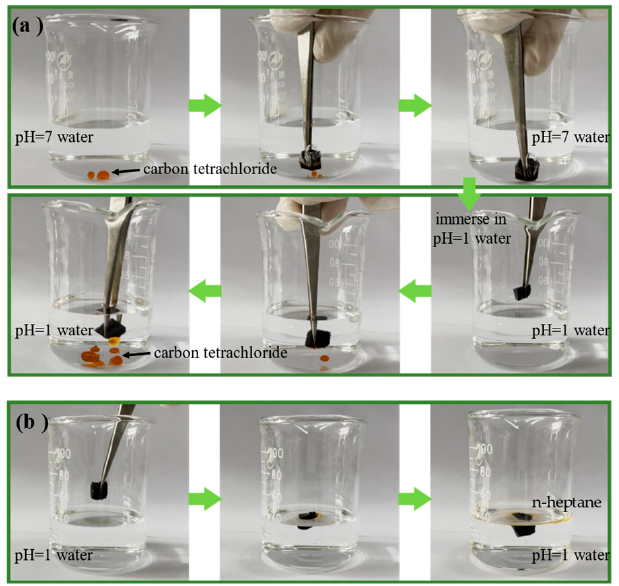
Figure 4. ( a ) Oil (carbon tetrachloride dyed with Sudan III) absorption in pH = 7 water and desorption in acidic water (pH = 1) by pH-responsive CF; ( b ) oil (n-heptane dyed with Sudan III) desorption by pH-responsive CF in acidic water (pH = 1).